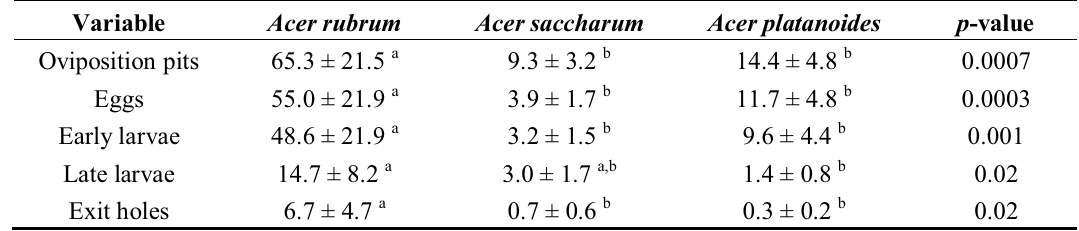
Table 4. Mean (±SE) estimates of life stages and signs of Asian longhorned beetle in three Acer species from the Boylston stand. Means followed by the same superscript letter within a row are not significantly different (Tukeys HSD, p >